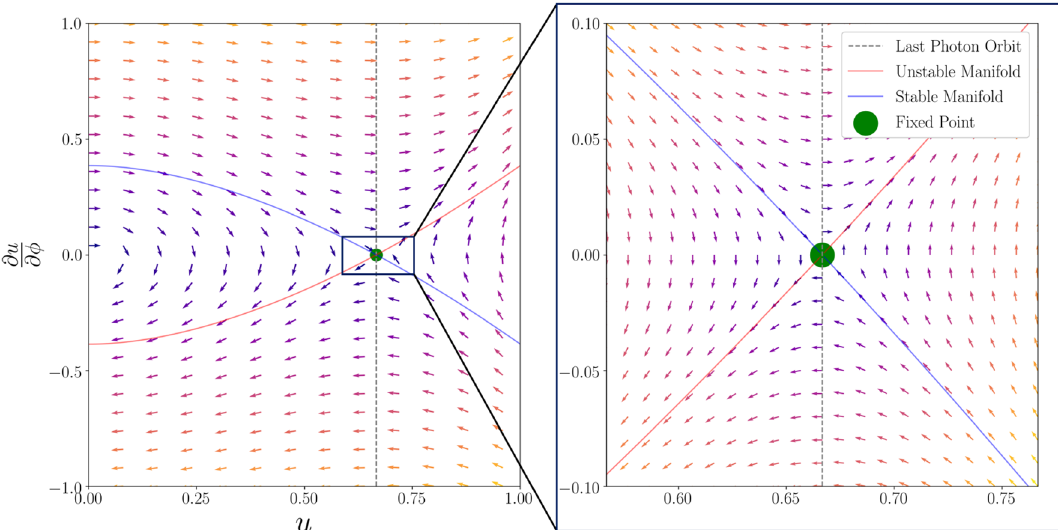
Figure 3. Entire (left) and zoomed-in (right) phase-space portrait for light trajectories obeying Eq. (3) with the arrows’ coloring indicating the magnitude of change (brighter hues implies longer vectors). u 2 0 represents infinity and u horizon, u 3 is at the photon sphere. If u = = = circular orbit, so this represents a fixed point. Notable, this is not a stable fixed point as deviations will in